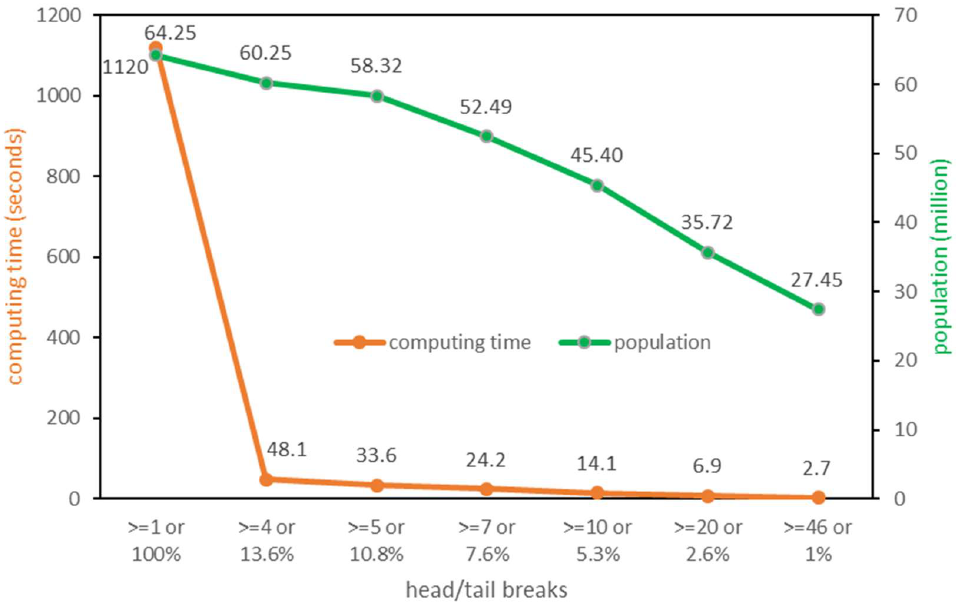
Figure 6. Performance of Louvain with head/tail breaks.